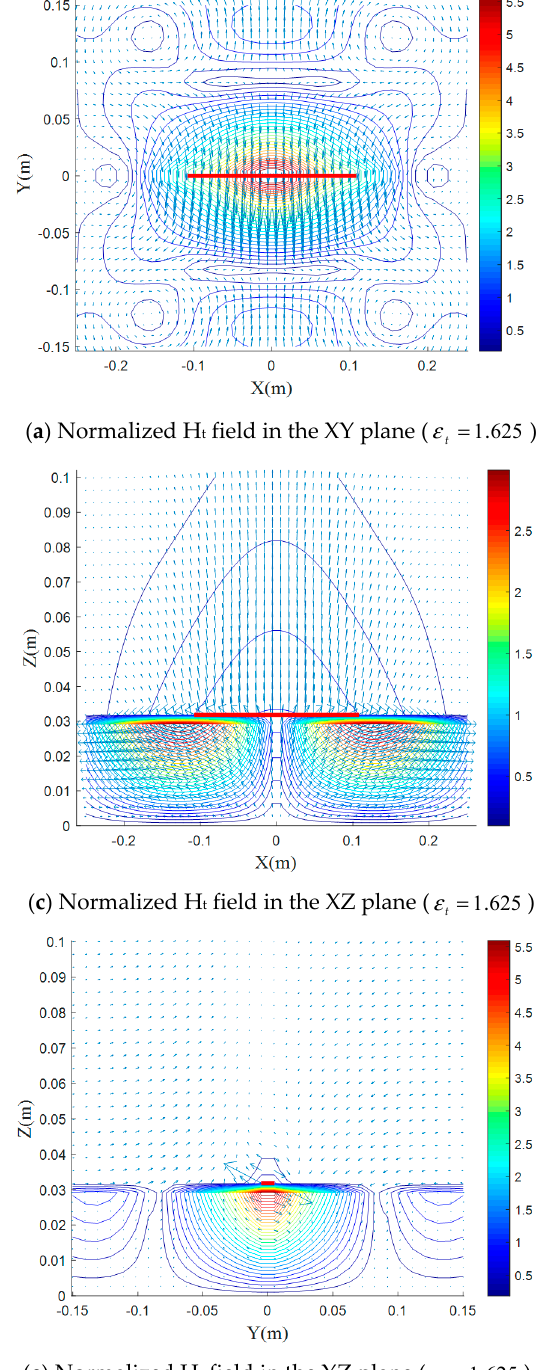
Figure 6. ( a – f ) Normalized magnetic field distributions for various values of XY, XZ and YZ planes.